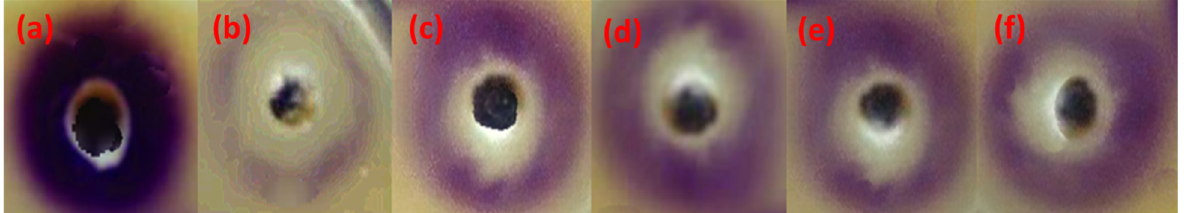
Figure 4. QS-inhibition assay on Soft Top agar of C. violaceum (CV026) biosensor strain of the most active derivatives: ( a ) CV026 pigment with DMSO served as negative control with no anti-QS activity; ( b ) anti-QS effect of 3,5-diaminopyrazole derivative 3a at 0.0625 µg/mL; ( c ) anti-QS effect of pyrazole derivative 5a at 0.187 µg/mL; ( d ) anti-QS effect of compound 6 at 0.125 µg/mL; ( e ) anti-QS of compound 9a at 0.187 µg/mL; and ( f ) anti-QS effect of compound 10a at 0.0625 µg/mL.